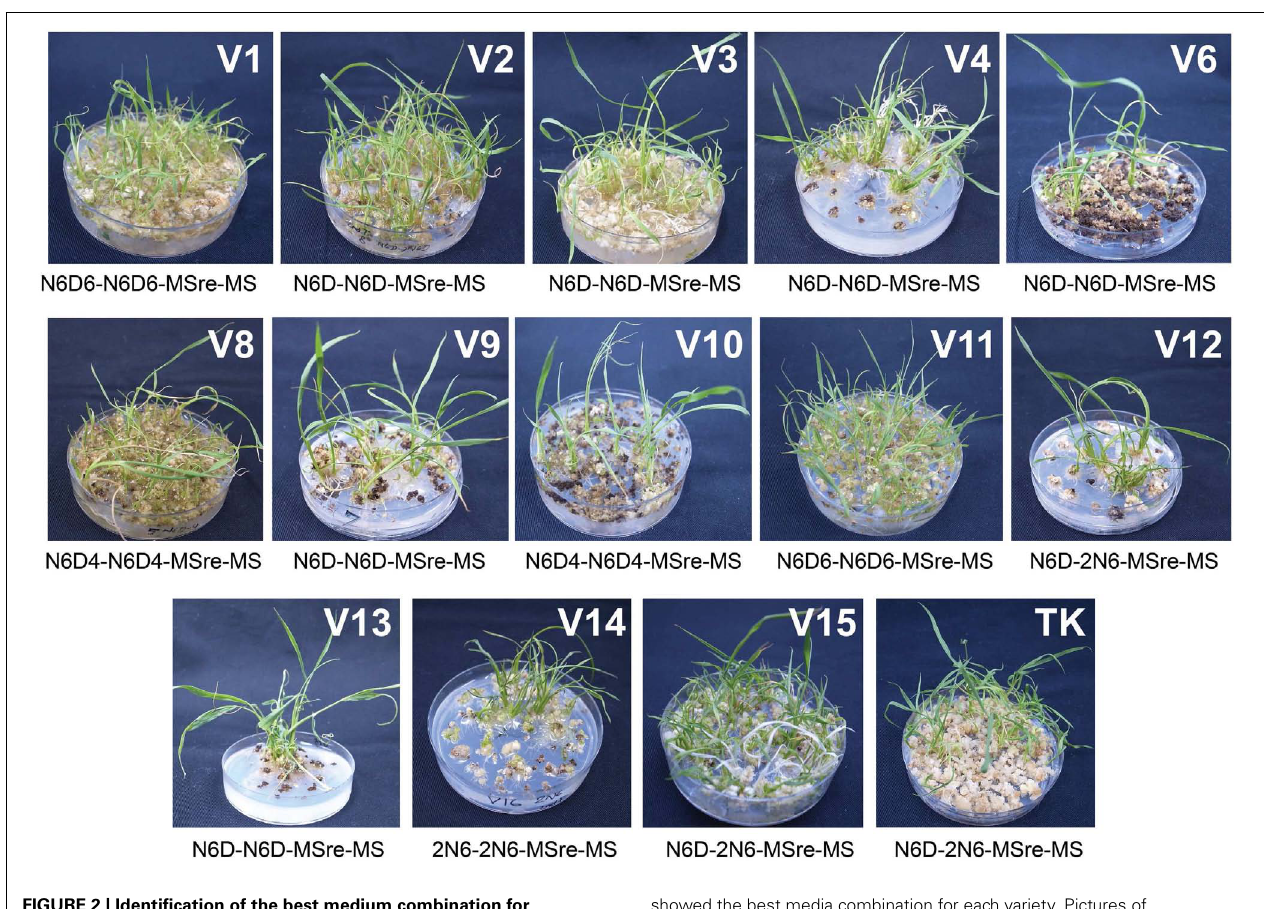
FIGURE 2 | Identification of the best medium combination for each variety .V1–V15 shown on upper right part of each picture represent the variety numbers described in Table 1 andTK means Tsukinohikari.The media combination described under each picture